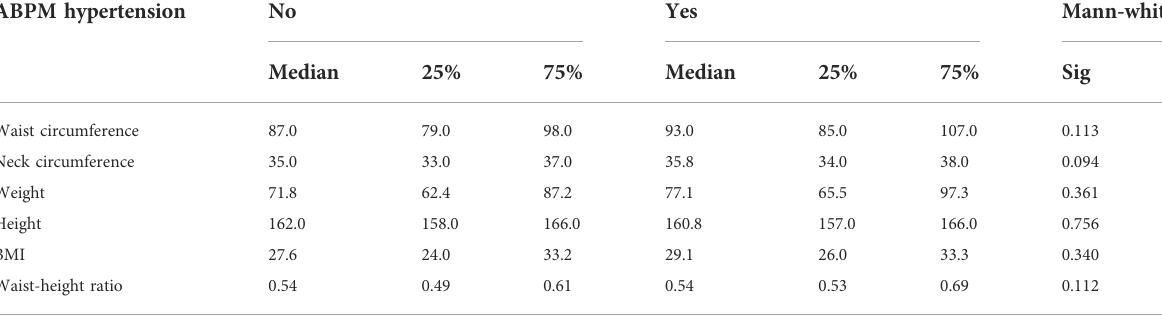
TABLE 6 Evaluation of the presence of hypertension (ABPM) according to anthropometric measurements. ABPM